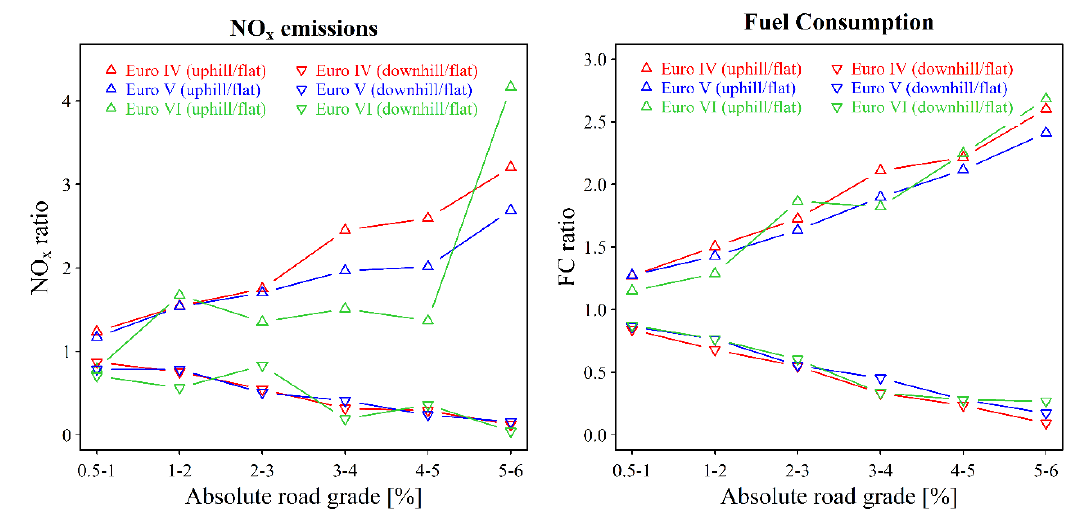
Figure 7. NO x emissions and fuel consumption (FC) ratios of uphill (road grade > +0.5%) and downhill (road grade < − 0.5%) driving over flat road driving ( | grade | < 0.5%) as a function of absolute road (road grade < −0.5%) driving over flat road driving (|grade| < 0.5%) as a function of absolute road grade classes for Euro IV, Euro V, and Euro VI HDDTs (500 m driving sequences grade classes for Euro IV, Euro V, and Euro VI HDDTs (500m driving sequences data).